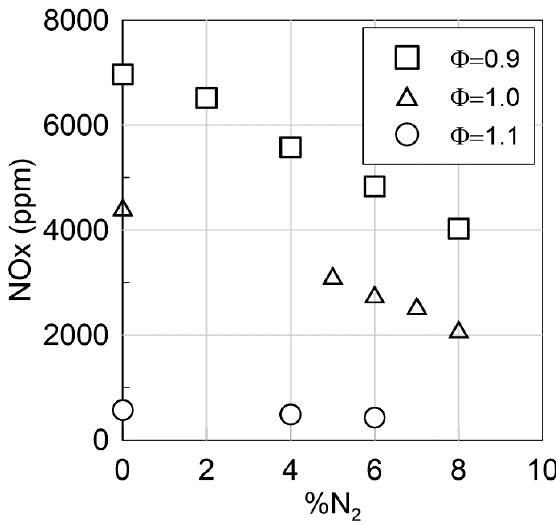
Figure 10. NOx vs %N 2 in total intake gases for pure ammonia. P in = 1.3 bar, 1500 rpm. Figure 10. NOx vs. %N 2 in total intake gases for pure ammonia. P in = 1.3 bar, 1500